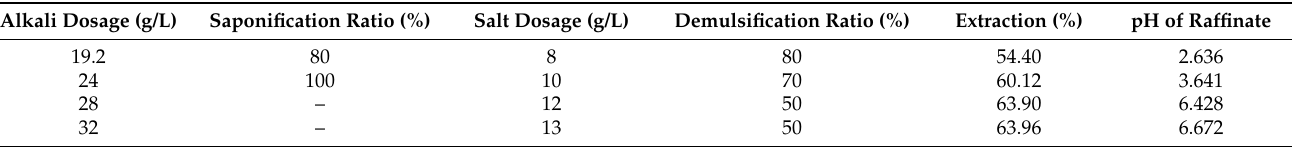
Figure 2. The relationship between the content of a salt compounded with alkali and weak acid and the ratio of demulsification (Conditions: 20% D2EHPA extractant, 3 M NaOH, 80% saponification ratio, and time 8 min). Table 3. The extraction of zinc after saponification pre-treatment and demulsification.